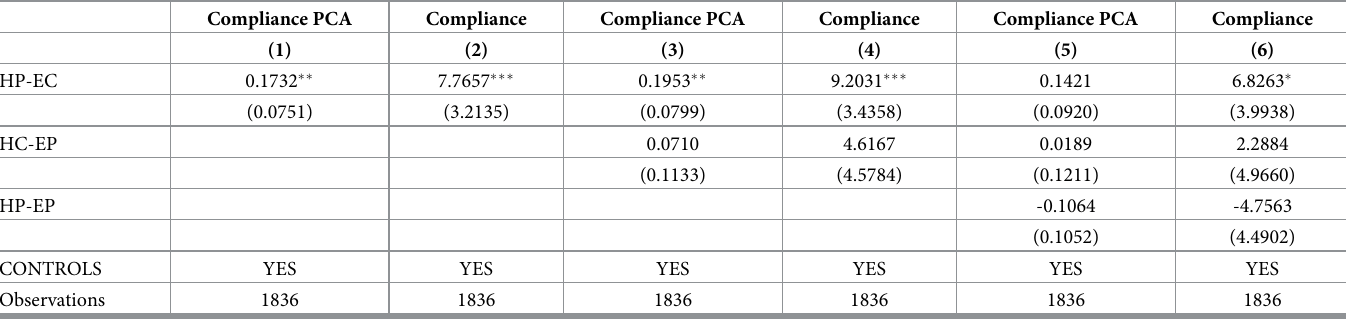
Table 5. Reduced form